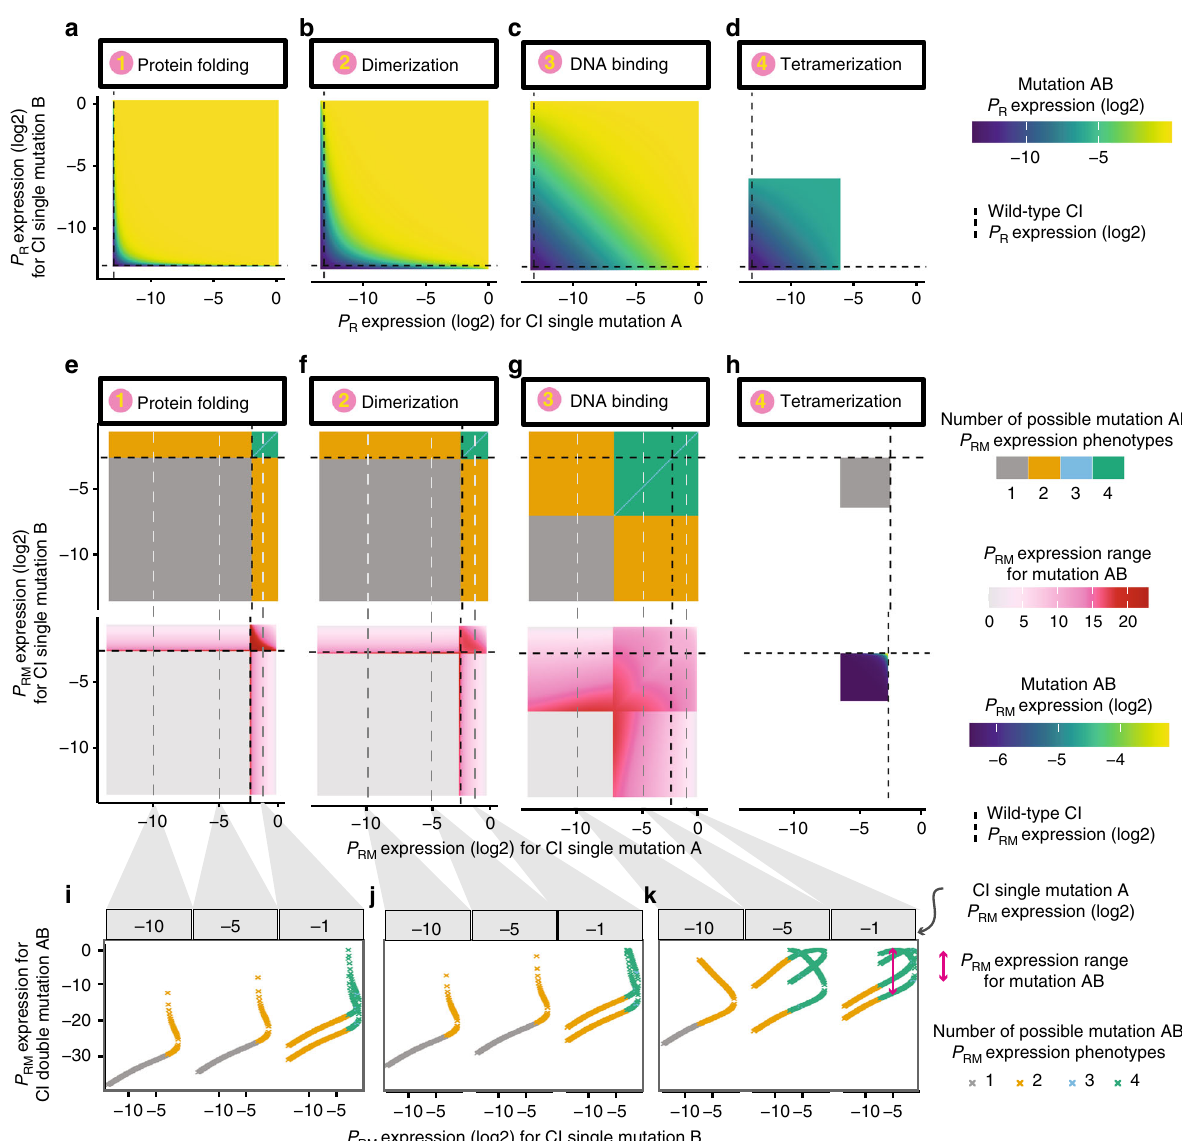
Fig. 2 Non-monotonicity results in ambiguous phenotype prediction. a – d Double mutant P R expression when combining CI mutations both affecting the same biophysical parameter: protein folding ( a ), dimerization ( b ), DNA binding ( c ) or tetramerization ( d ). e – h Double mutant P RM expression when combining CI mutations affecting the same biophysical parameter: protein folding ( e ), dimerization ( f ), DNA binding ( g ) or tetramerization ( h ). Top row panels show number of possible P RM expression phenotypes when combining two single mutant phenotypes. Bottom row panels ( e – g ) show the range of possible P RM phenotypes. Bottom row of ( h ) shows P RM expression since there is no ambiguous prediction. i – k Examples showing how three mutations with known P RM expression phenotypes combine with second mutations with known phenotypes to result in up to four different expression levels in the double mutant. Source data are provided as a Source data fi